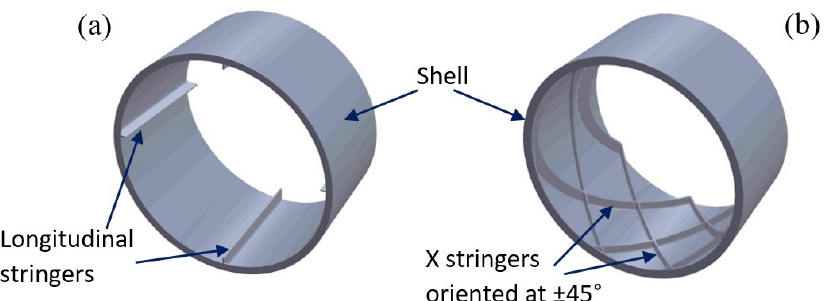
Figure 1. Composite structures of the fuselage section type. ( a ) fuselage section with straight (longitudinal) stringers; ( b ) fuselage section with stringers in two directions at ± 45 ◦ . Table 1. Dimensions of fuselage section and stringers subjected to compression test.